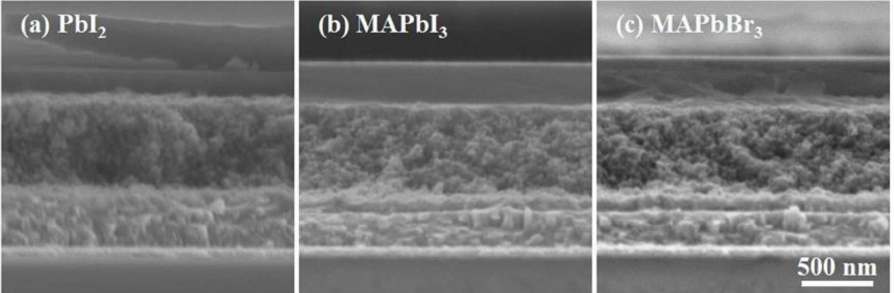
Figure 6. Cross-section SEM images of ( a ) PbI 2 , ( b ) MAPbI 3 , and ( c ) MAPbBr 3 deposited on a mesoporous TiO 2 film. (Figure reprinted from Zhao et al. [89], copyright (2023) with permission of Faraday Discussions,